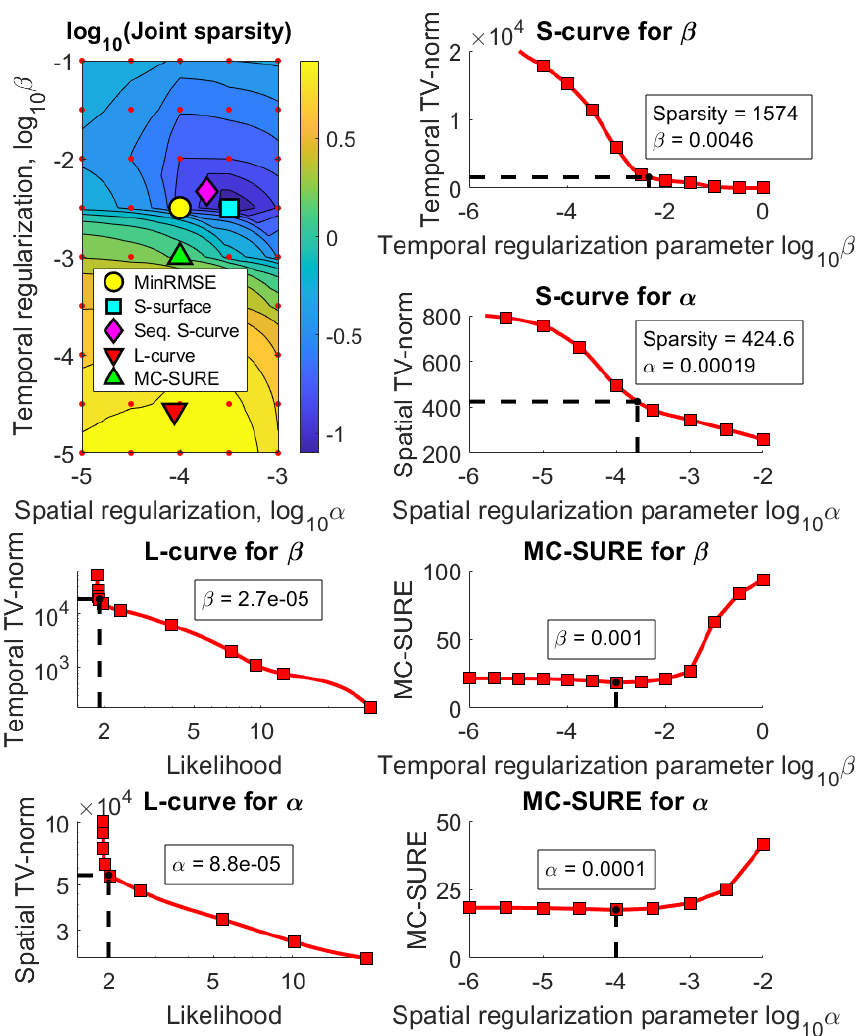
Figure 3. The joint sparsity contour used in the S-surface parameter selection as well as all the parameter selection curves for Sequential S-curve, L-curve and MC-SURE in the simulation with noise level 5%. The red dots mark the computational grid of α :s and β :s in the contour, and the red squares mark the 1D grid of regularization parameters in the parameter selection curves. Note that the spatial TV norm for the Sequential S-curve is from a single image frame whereas the spatial TV norm for the L-curve is from the whole image